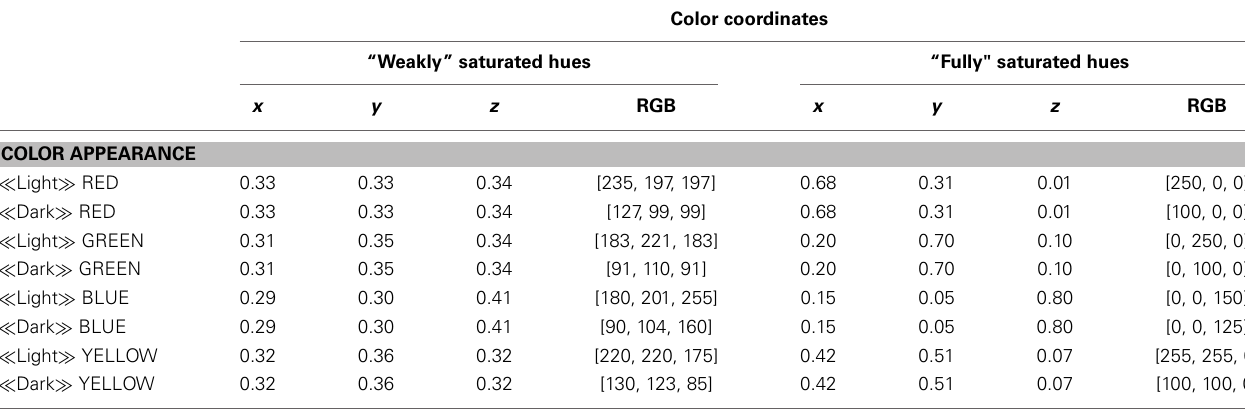
Table 1 | Color coordinates (X, Y, Z) and RGB (Adobe) triplets associated with the different hues (shown on their gray backgrounds here in Figure 3).